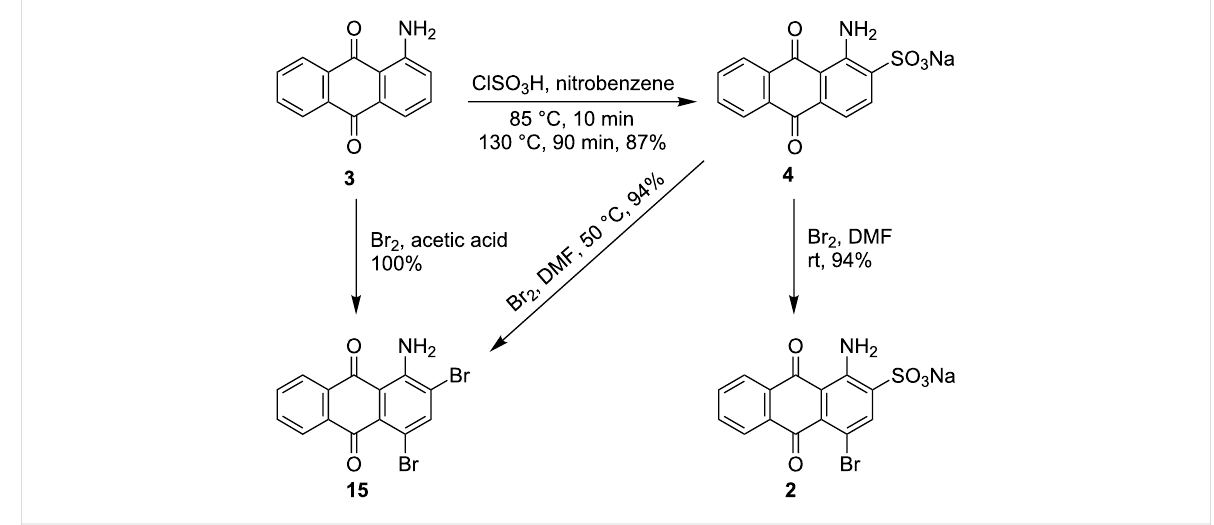
Scheme 4: Synthesis of 2-substituted 1-amino-4-bromoanthraquinone derivatives 2 and 15 .